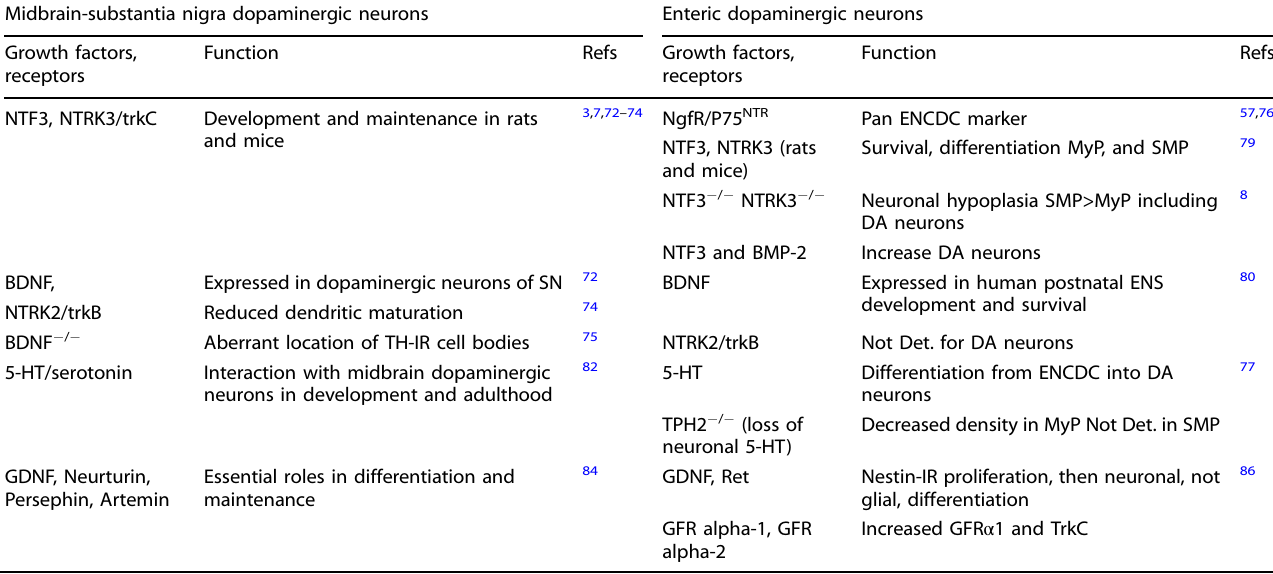
Table 3. Compared neurotrophic factors signaling in the differentiation survival and maintenance of dopaminergic neurons in the midbrain and the enteric nervous